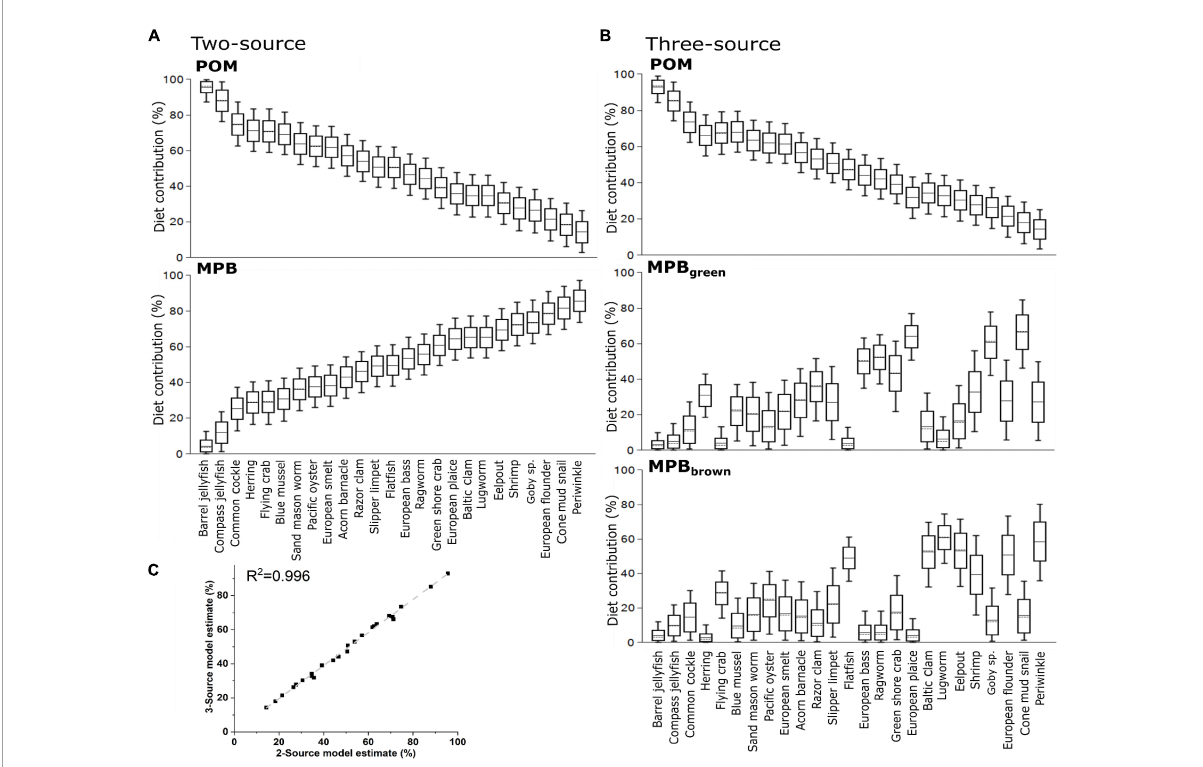
FIGURE5 Estimated dietary contributions from primary producers using (A) a two source mixing model using only δ 13 C and mean values for each species and (B) a three source mixing model using both δ 13 C and δ 15 N Phe − Base and mean values for each species and (C) the correlations between two and three source mixing models when applied to means values and individuals for each species. Trophic structure has been accounted for in both models using trophic-level estimates from amino acid analysis of δ 15